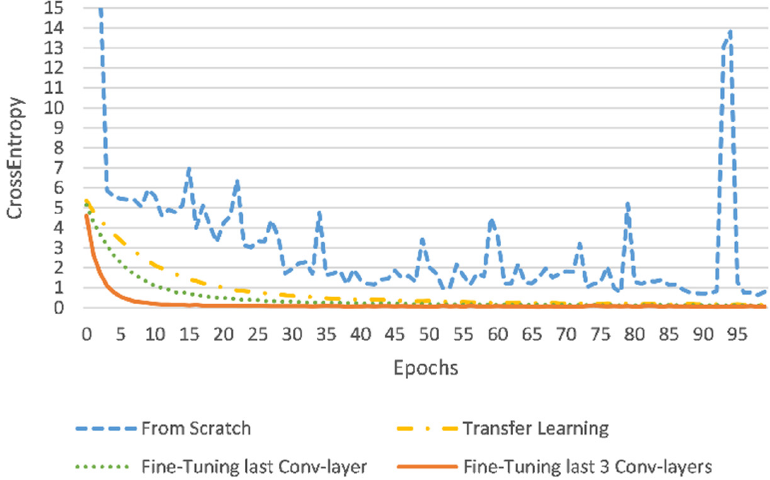
Figure 6. Validation loss of the proposed model in different settings.